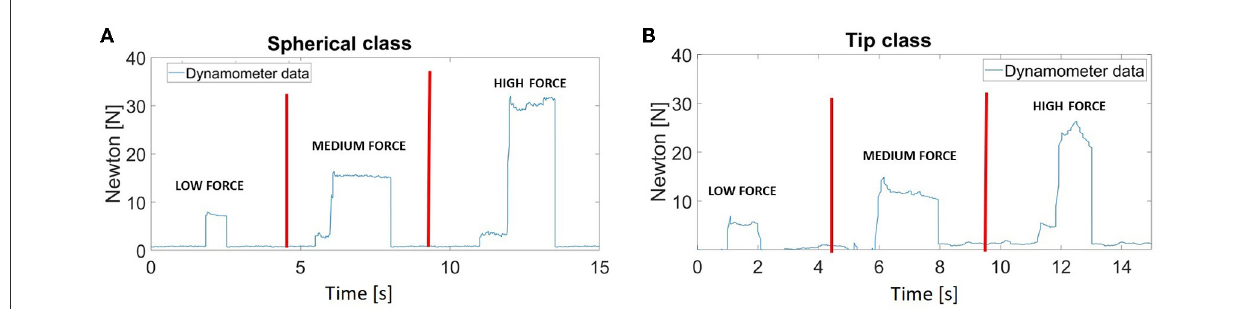
FIGURE7 The dynamometer data showed the force signals obtained when the prosthesis applied the three force levels (low, medium, and high) during the spherical (A) and tip class (B) .